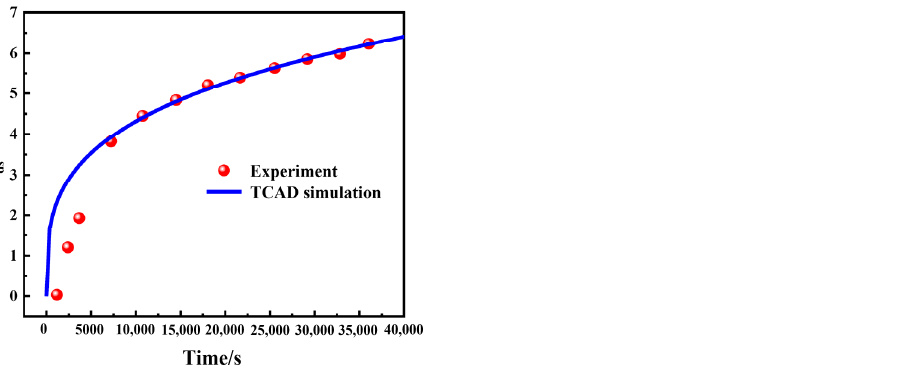
Figure 7. Comparison of the degradation trend of Δ I ds with time between Ref. [13] and this work under the hot ‐ electron stress of V ds = 30 V.